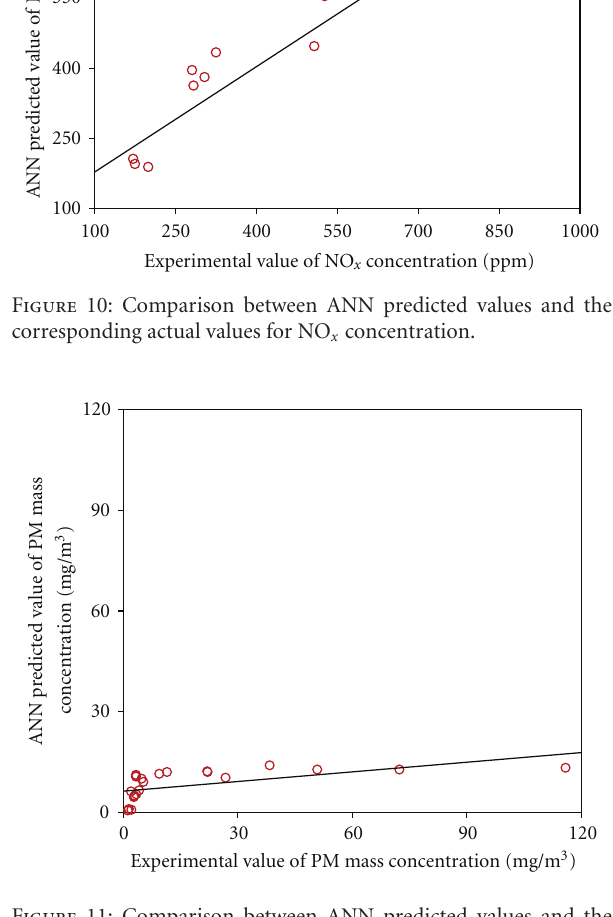
Figure 9: Comparison between ANN predicted values and the corresponding actual values for BTE.